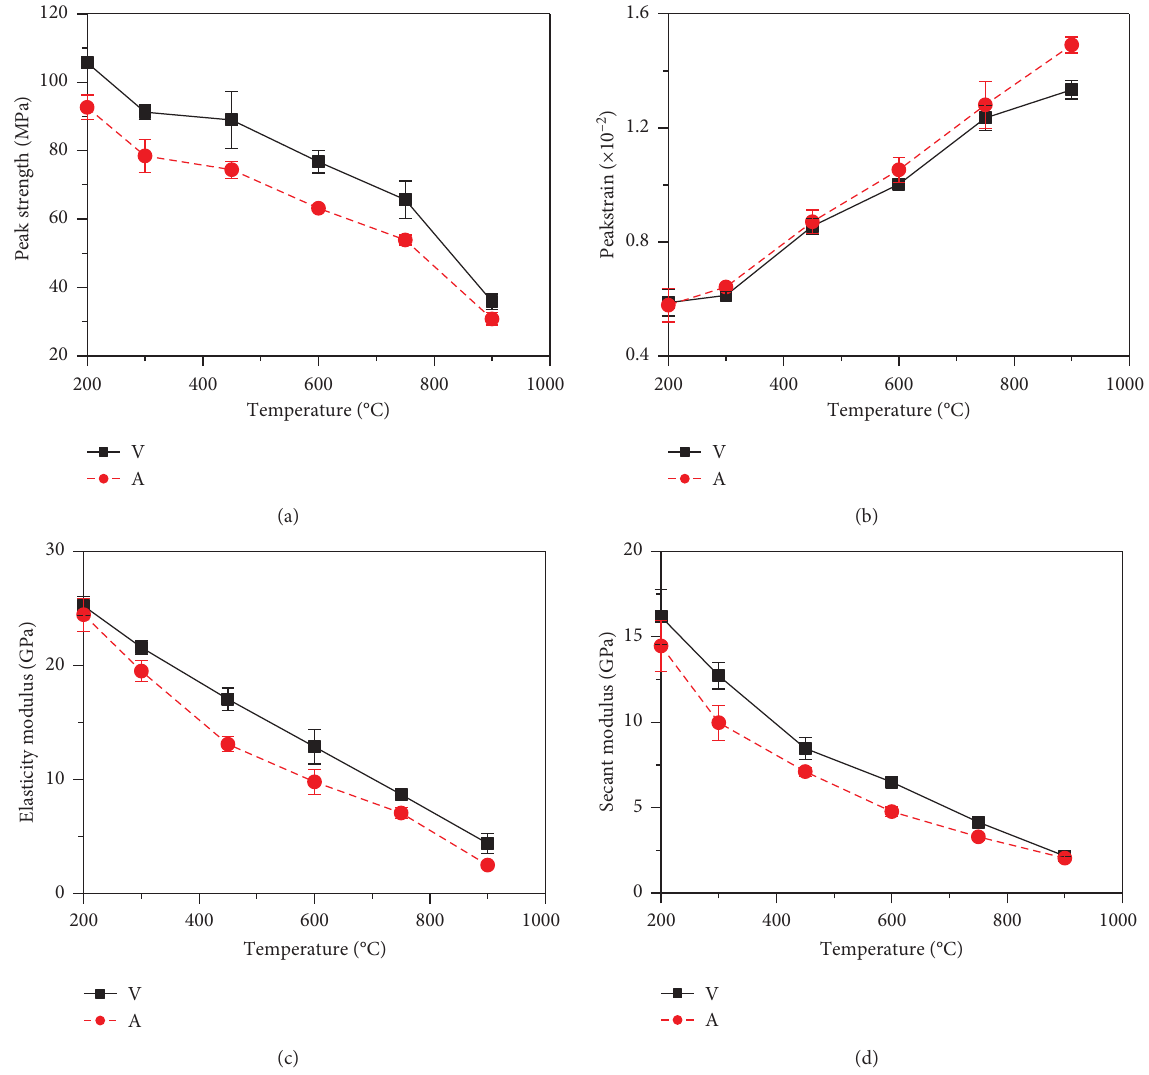
Figure 5: Variations in (a) peak strength, (b) peak strain, (c) elasticity modulus, and (d) secant modulus versus the treated temperature (error bar indicates one standard